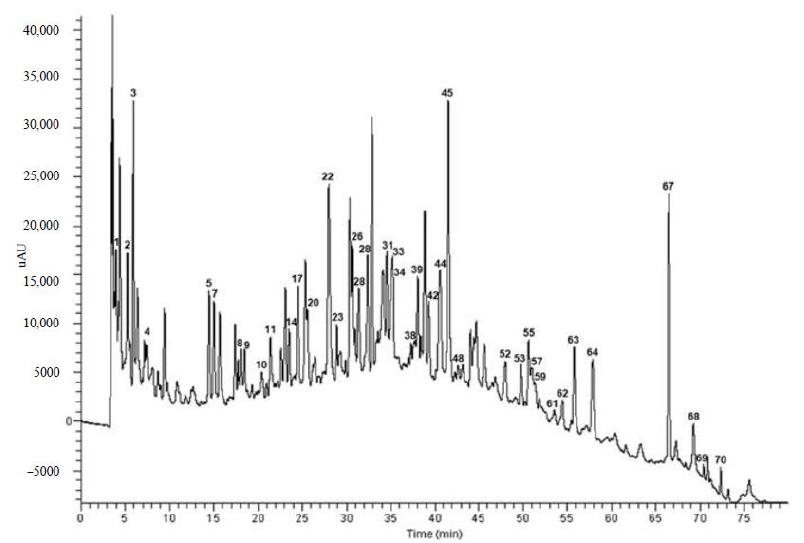
Figure 2. HPLC-UV chromatogram recorded at 280 nm of phenolic compounds present in grape cane extract at pH 1.00 from “Aglianico” cultivar. For chromatographic conditions, see Section 3.3.6. For peak assignments, see Table 1.